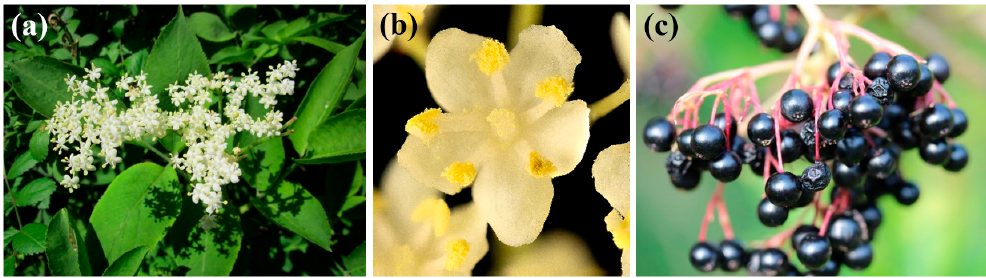
Figure 1. ( a ) Inflorescences and leaves, ( b ) flowers, and ( c ) fruits of Sambucus nigra